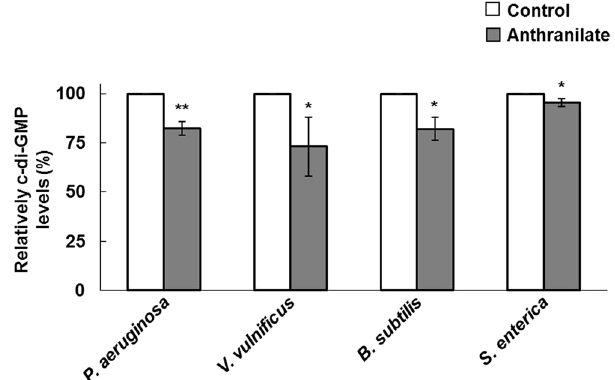
Figure 6. Reduction of intracellular c-di-GMP by anthranilate Intracellular c-di-GMP levels in various bacteria were measured after treatment with 0.1 mM anthranilate using a Thiazole orange (TO)-based fluorescence assay. Results are presented as percentages of the control. * p < 0.05; ** p < 0.01.